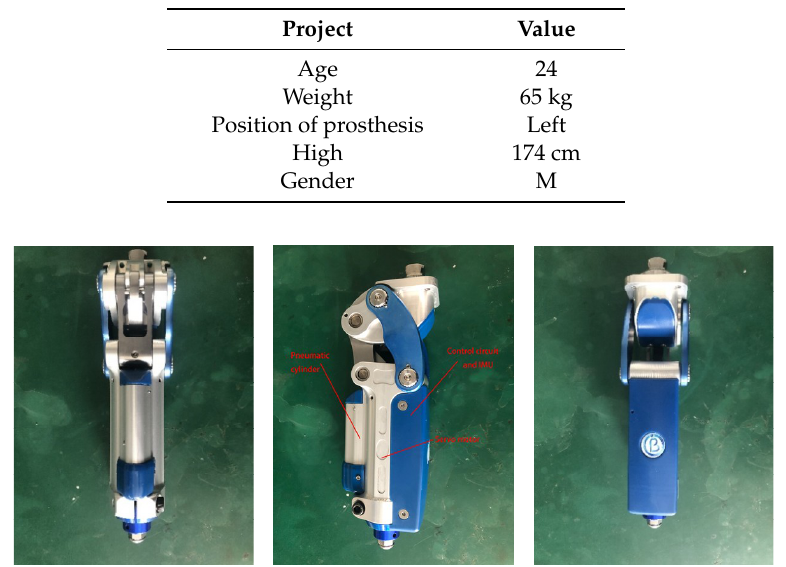
Figure 15. The artificial knee. The position of the pneumatic cylinder, servo motor and control circuit with inertial measurement unit (IMU) have been pointed out.